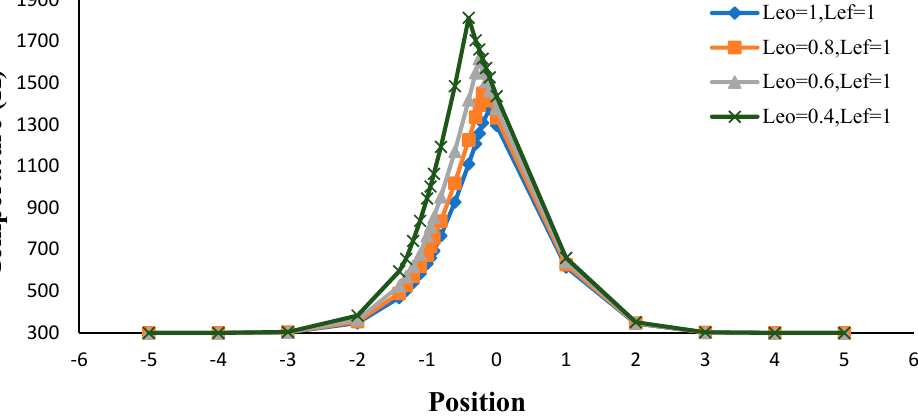
Figure 11. Temperature distribution against position for different oxidizer Lewis numbers.